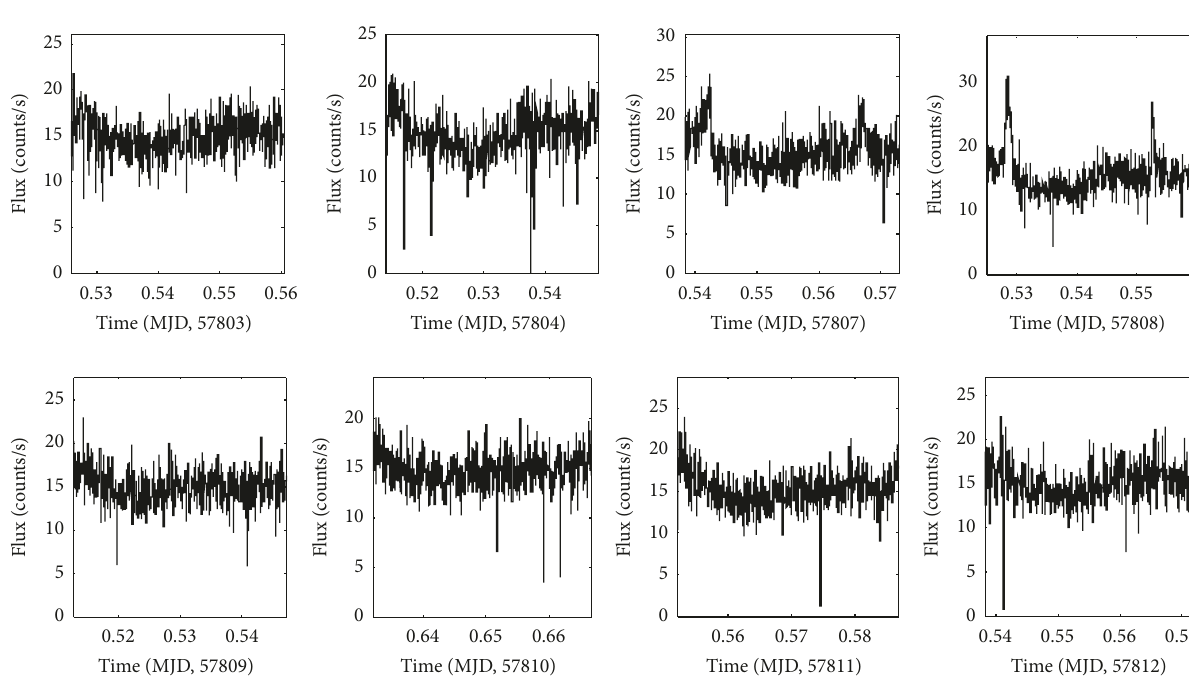
Figure 4: TSXS flux data of eight observations on